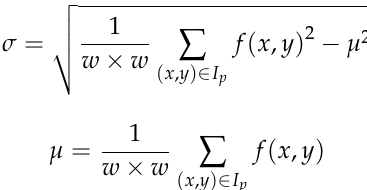
Table 2. Parameters of fuzzy sets of antecedent variables.